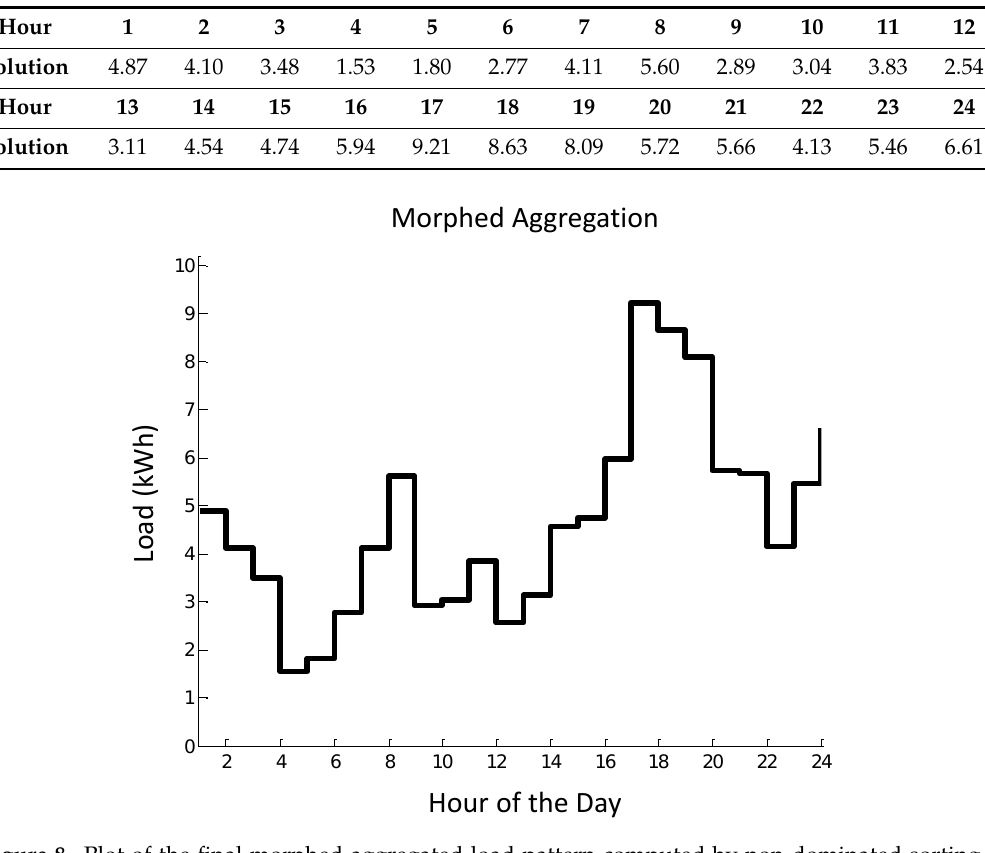
Figure 8. Plot of the final morphed aggregated load pattern computed by non-dominated sorting genetic algorithm-II (NSGA-II) (Values taken from Table 1).